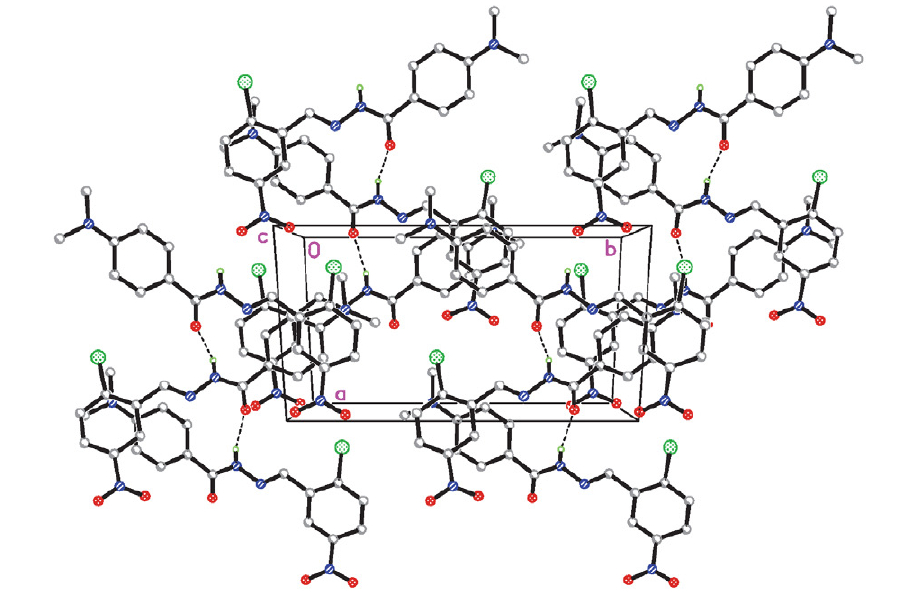
Figure 5. The packing diagram of 2 . Hydrogen bonding interactions are shown as dashed lines.